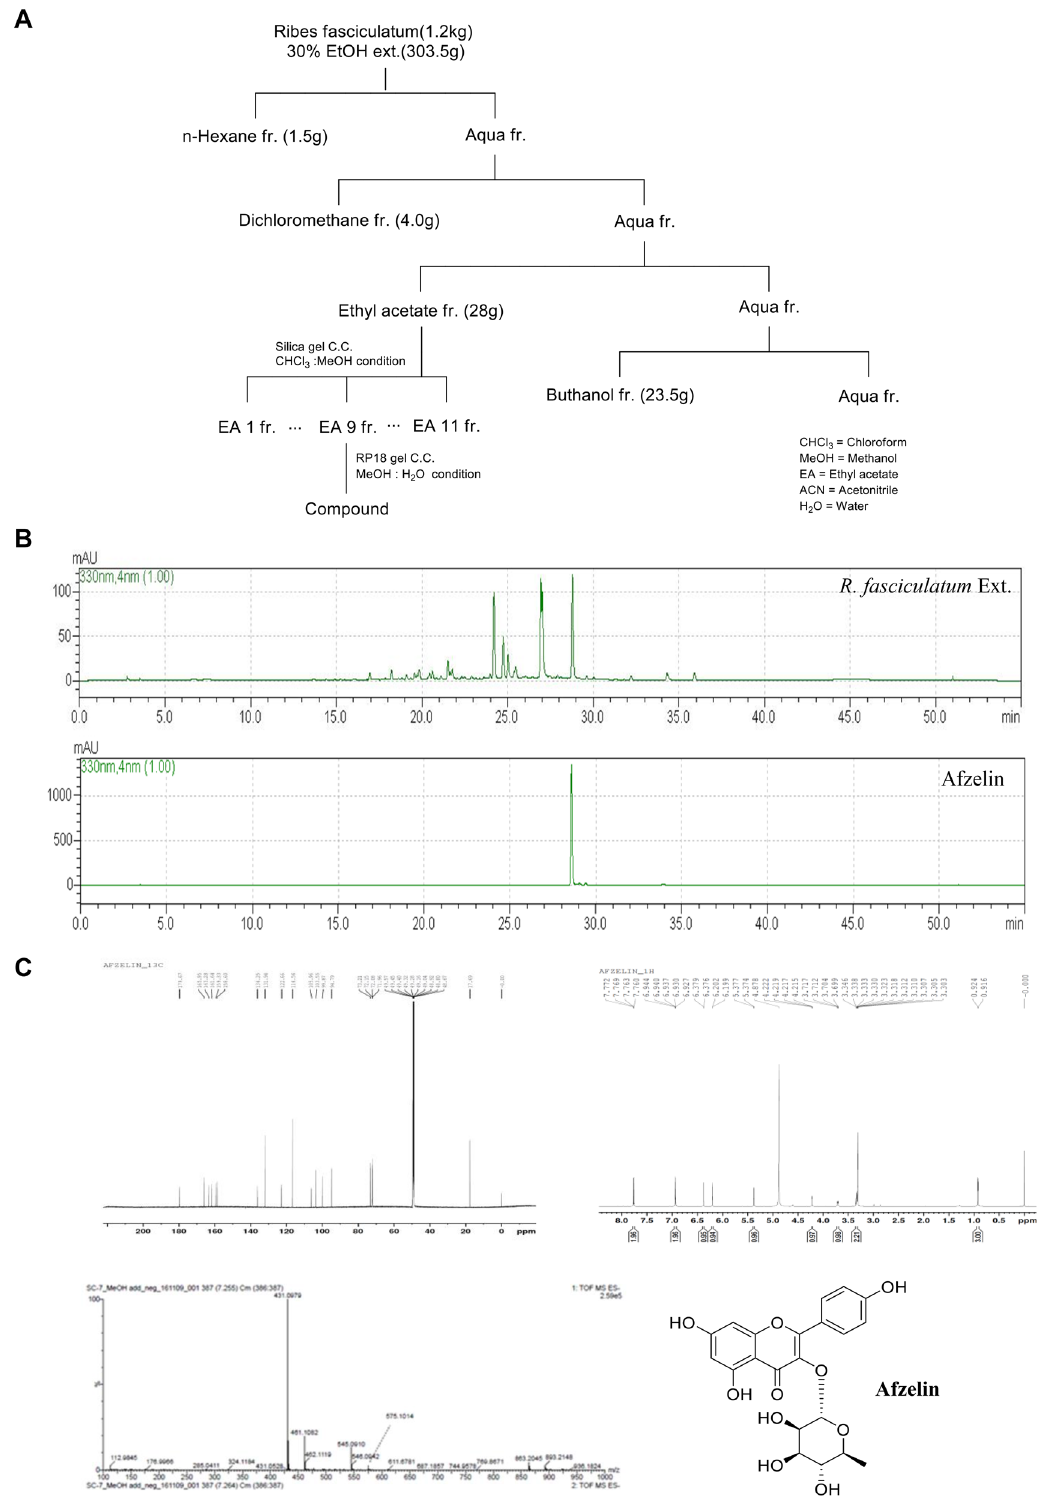
Figure 1. Isolation and structural analysis of afzelin from Ribes fasciculatum extract. Isolation scheme of compound from R. fasciculatum ( A ), HPLC profile of R. fasciculatum Extract and afzelin ( B ), 13